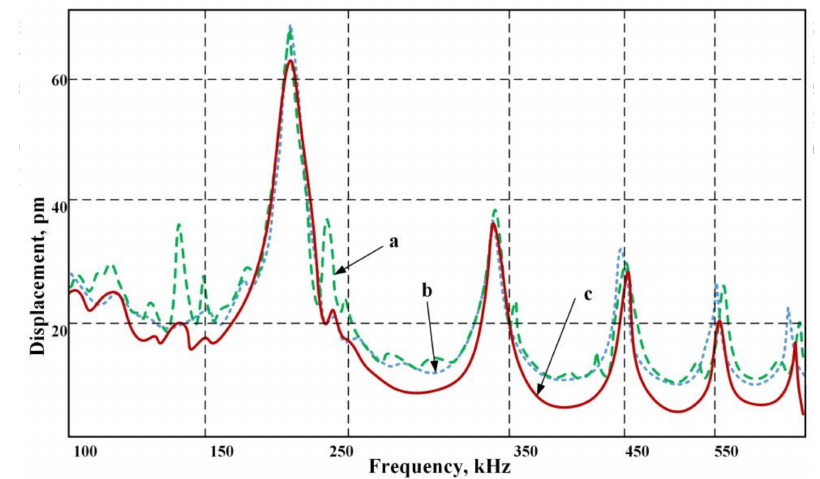
Figure 7. Frequency average spectrum of the actuator scanned surface obtained by measurement via a 3D scanner: ( a ) without fluid; ( b ) with the water suspension; ( c ) with the biological suspension-viscous fluid.